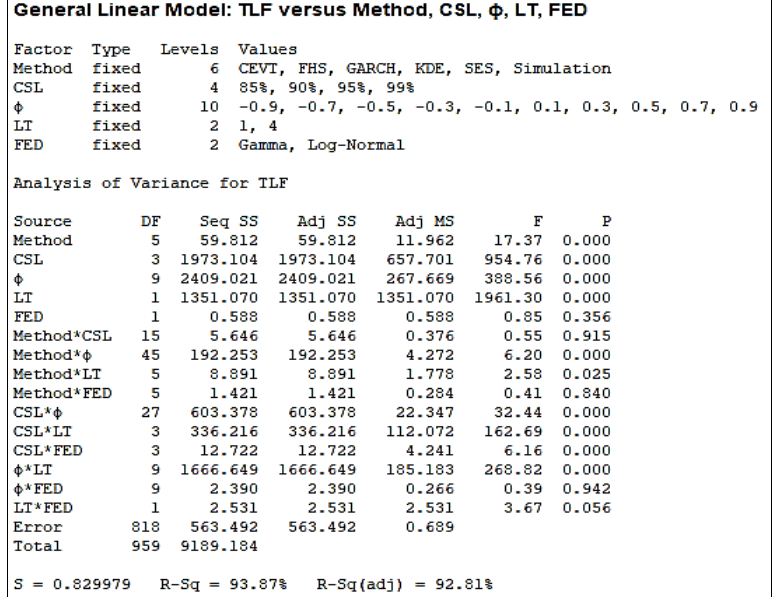
Figure 12. ANOVA results applied to TLF as output response and Method, CSL, ϕ, LT, and FED as inputs.